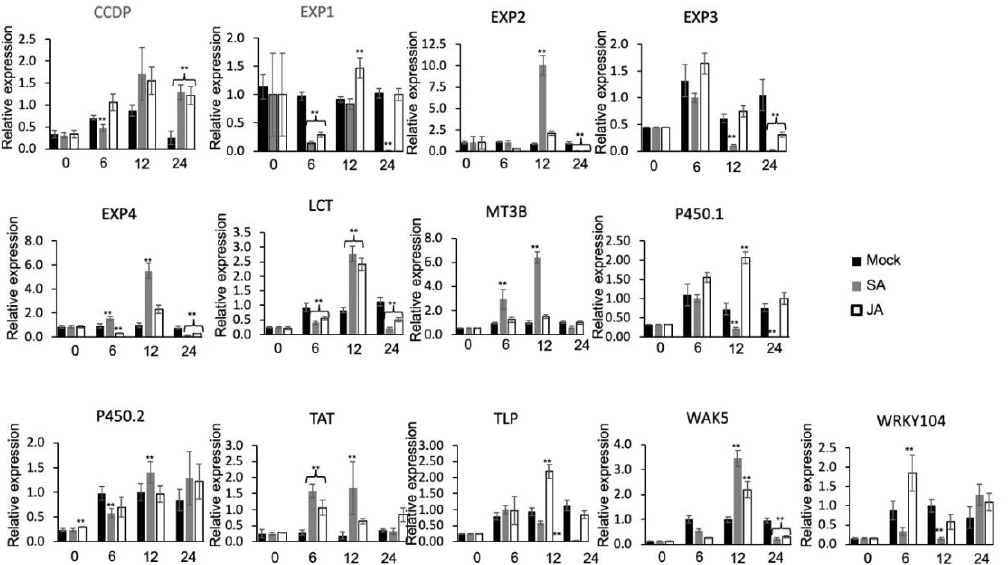
Figure 7. The expression level of K2-DEGs in rice at 0, 6, 12, and 24 h after treatment with 100uM salicylic acid (SA) (C 7 H 6 O 3 ) and 100uM jasmonic acid (JA) (C 12 H 18 O 3 ). Data presented are the means ± SD from 3 replicates and ** above the bars indicate significant differences at p < 0.05 level between the treatment and mock at the same time points. Genes were coded as follows: CCDP (AK062654), EXP1 (NM_001069356), EXP2 (LOC_Os08g26230.4), EXP3 (NM_001189913), EXP4 (LOC_Os09g04310.1),